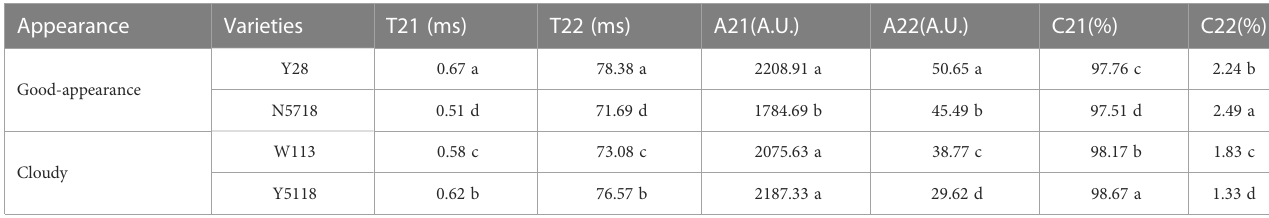
TABLE 4 Moisture distribution state indicators of the four varieties.